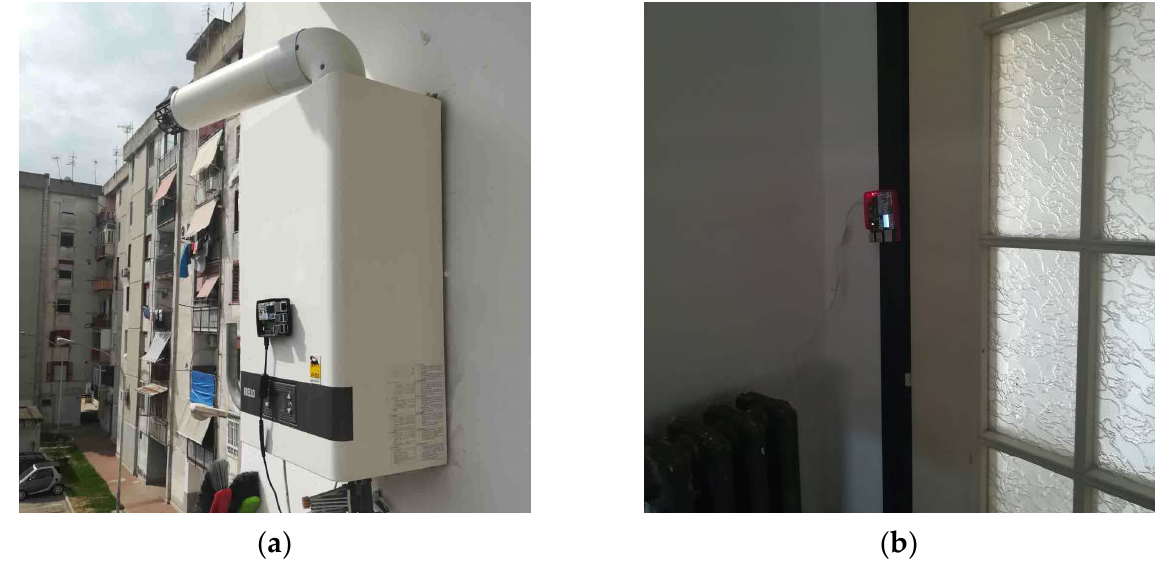
Figure 7. The sensors installed at the Ponticelli building: ( a ) Outdoor installation; ( b ) Indoor installation.